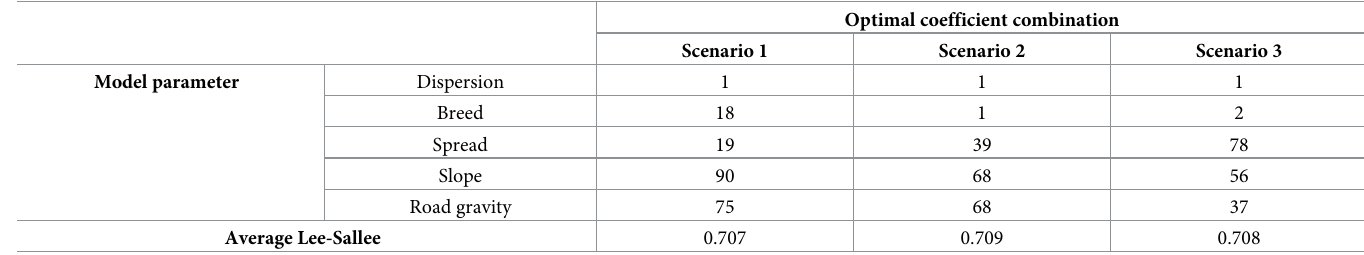
Table 2. Calibration results of the three